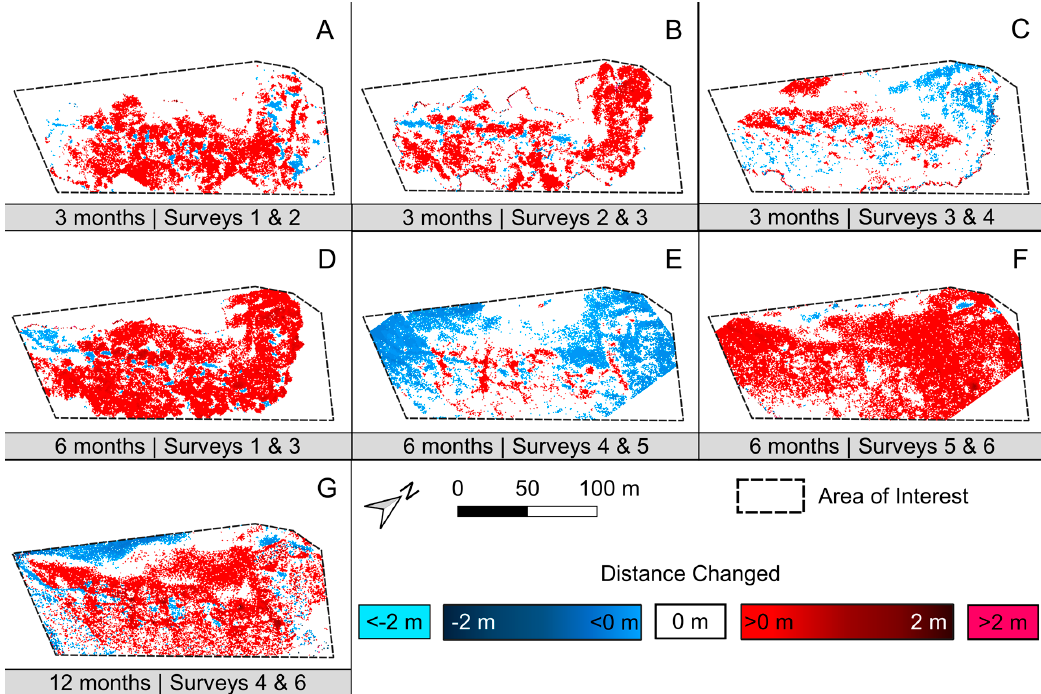
Figure 8. Significant differences indicated by M3C2-PM comparisons between pairs of dense clouds. Changes were mostly between − 2 and 2 m as indicated by the split colour ramps. Rasters were created from change clouds at a resolution of 0.75 m, with the mean of intersecting points in horizontal space assigned as the value in each cell and cropped to the area of interest (Figure 1). Panels ( A – G ) show rasterised M3C2-PM differences for pairs of surveys explored in intra- and inter-annual KAP